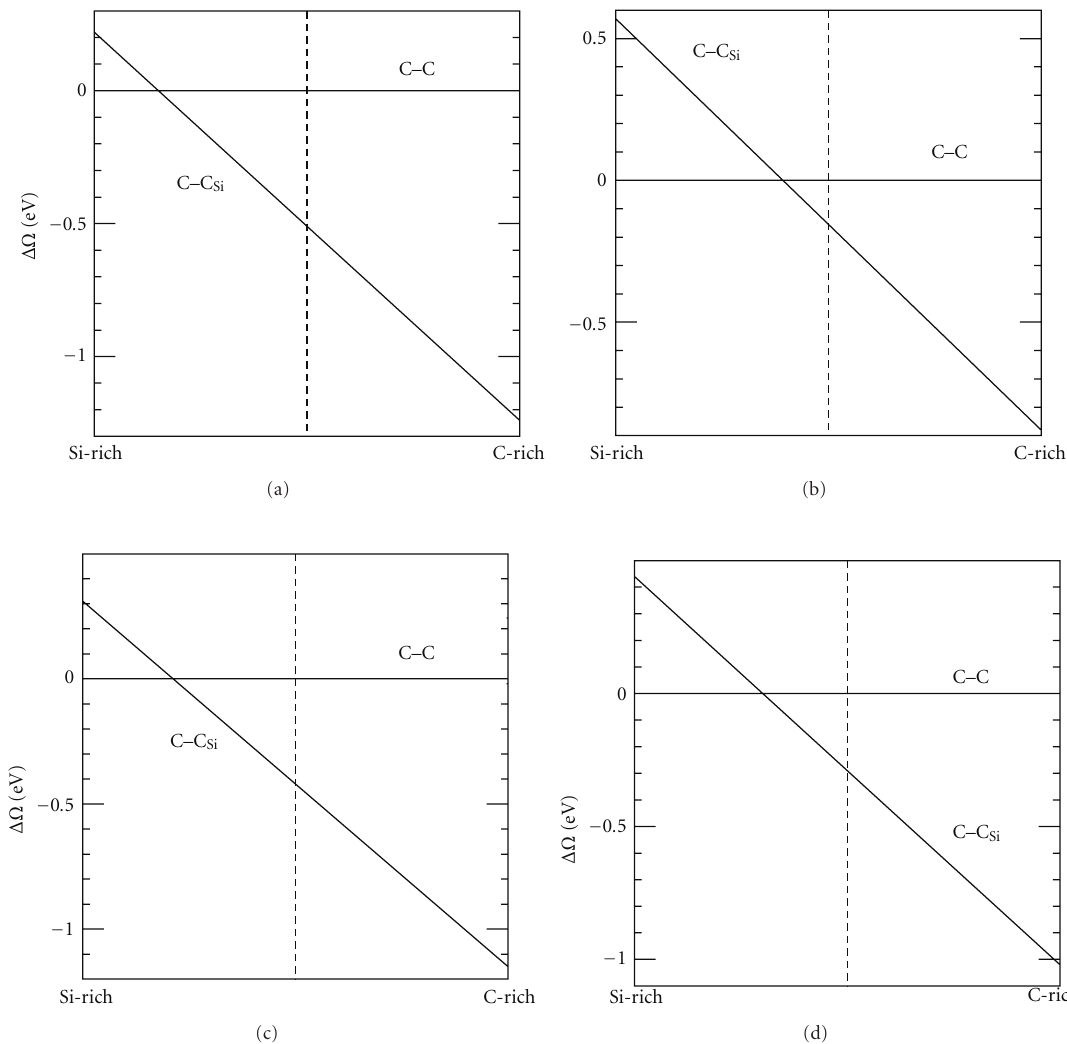
Figure 4: Relative formation energies ( ΔΩ ) of C–C and C–C Si defects in (a) 3C–SiC bulk, (b) C-coated [100] SiC NW, (c) Si-coated SiC NW, and (d) [111] SiC NW. The vertical dashed lines indicate the stoichiometric